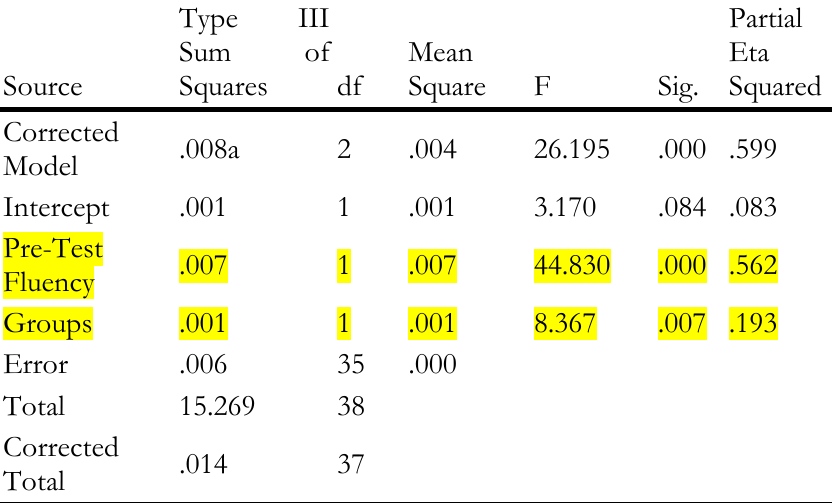
Partial Eta Squared